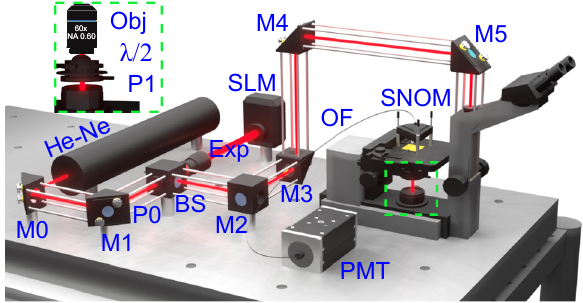
Figure 9: Experimental setup. Experimental setup: (He–Ne) helium-neon laser, (M0–M5) dielectric mirrors, (P0, P1) linear polarizers, (BS) beamsplitter, (Exp) beam expander, (SNOM) scanning near-field optical microscope, ( λ /2) half-wave plate, (Obj) 60 × objective (NA = 0.6), (OF) optical fibre, (PMT) photomultiplier